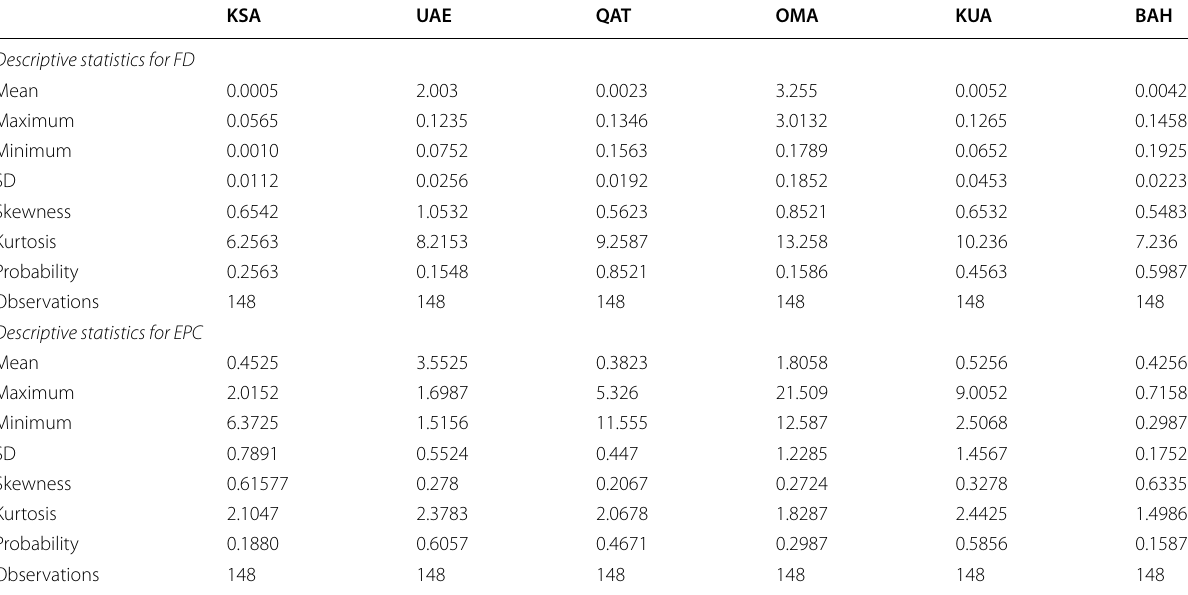
Table 1 Descriptive statistics for the FD and EPC in